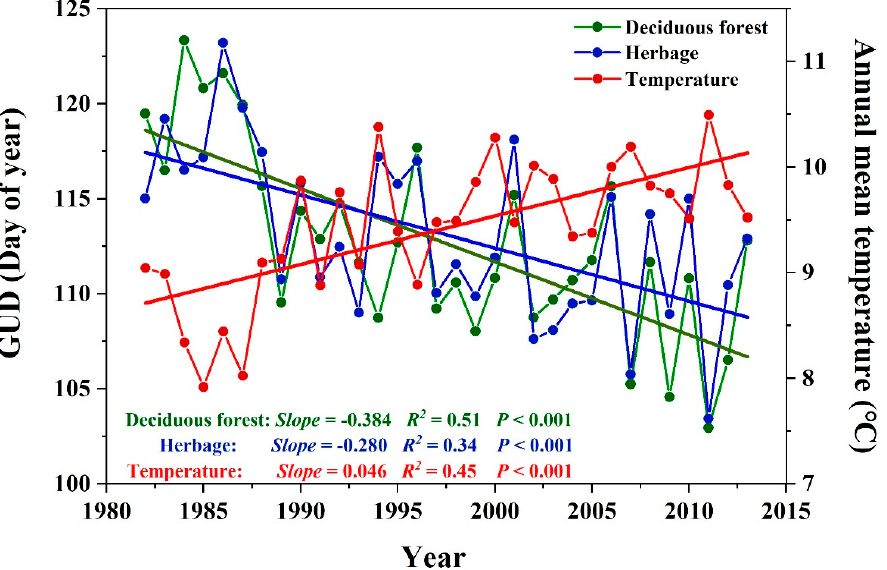
Figure 3. Interannual variation and trends in vegetation green-up dates (GUD) for deciduous forest and herbages, and annual mean temperature from 1982 to 2013 over the selected 58 forest-herbage- mixed (FHM) sites.